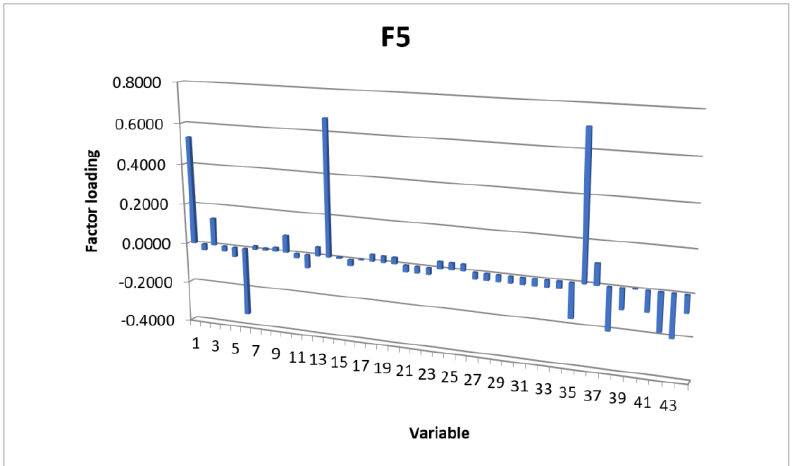
Figure 10. Graphic depiction of factor loads values for input variables for factor F5.